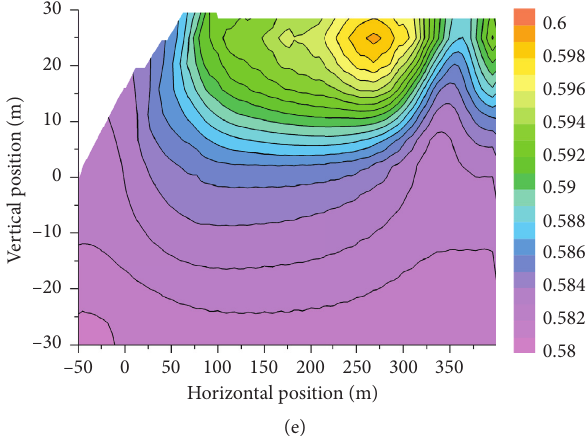
Figure 8: Contour of horizontal displacement of various parts of the ash storage field. (a) L (d) L d � 150m, (e) L d � 200m.